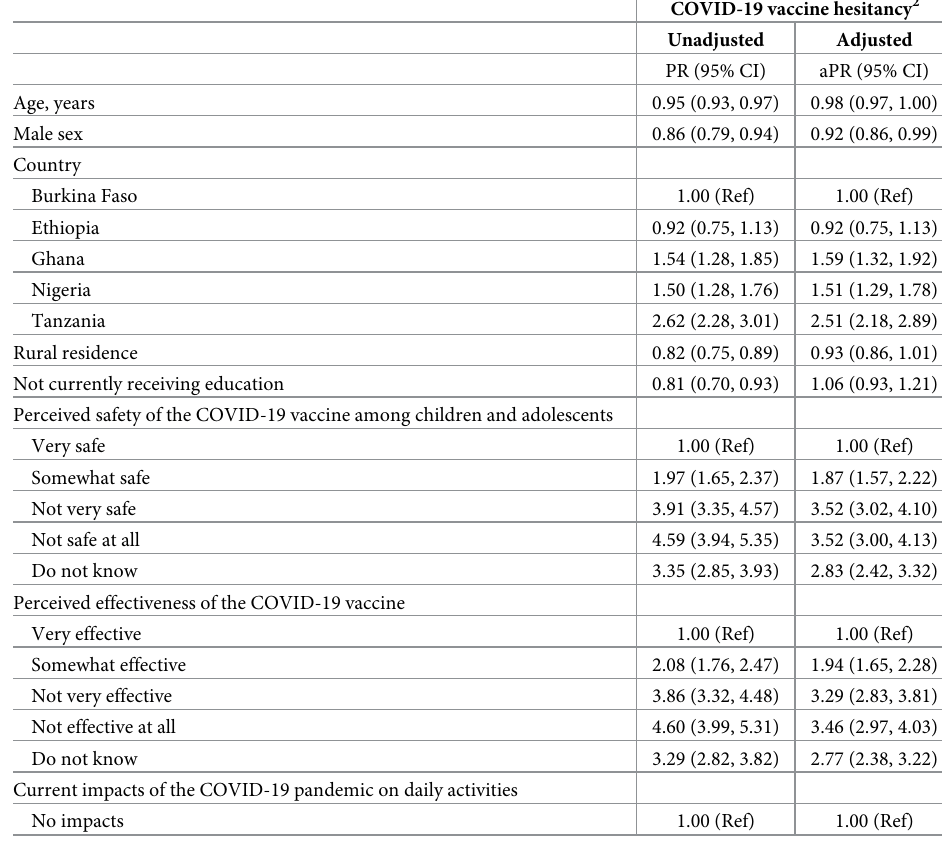
Table 3. Potential determinants of COVID-19 vaccine hesitancy among adolescents in a phone-based survey in five sub-Saharan African countries, 2021 1 .